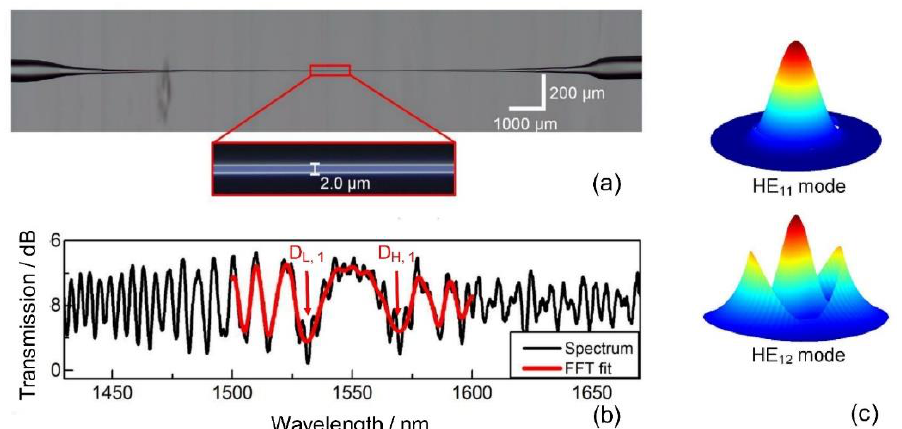
Figure 6. ( a ) The microscopic view of the tapered optical microfiber; ( b ) the origin (black) and the fast Fourier transform (FFT)-filtered (red) transmission spectra of the tapered few-mode microfiber surrounded by air; ( c ) the simulated mode profiles of HE 11 and HE 12 modes. Adapted with permis- sion from Ref. [28].